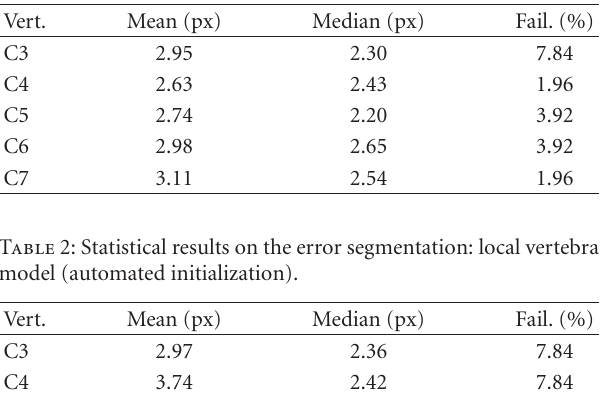
Table 1: Statistical results on the error segmentation: local vertebra model (manual initialization).